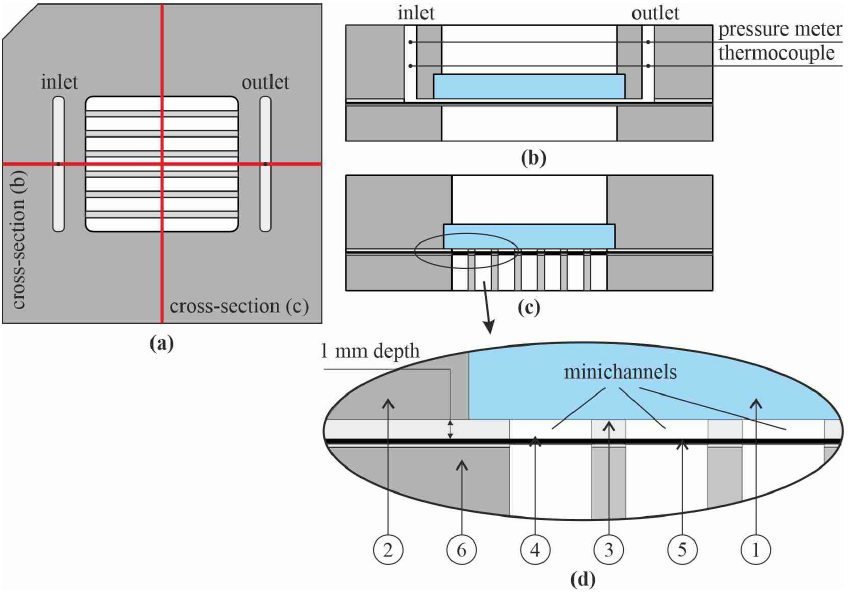
Figure 3. The test section: ( a ) top view and ( b , c ) cross ‐ sections, ( d ) enlarged detail; 1—glass plate, 2—channel body, 3, 5—spacers, 4—heated foil, 6—front cover. 2—channel body, 3, 5—spacers, 4—heated foil, 6—front cover.